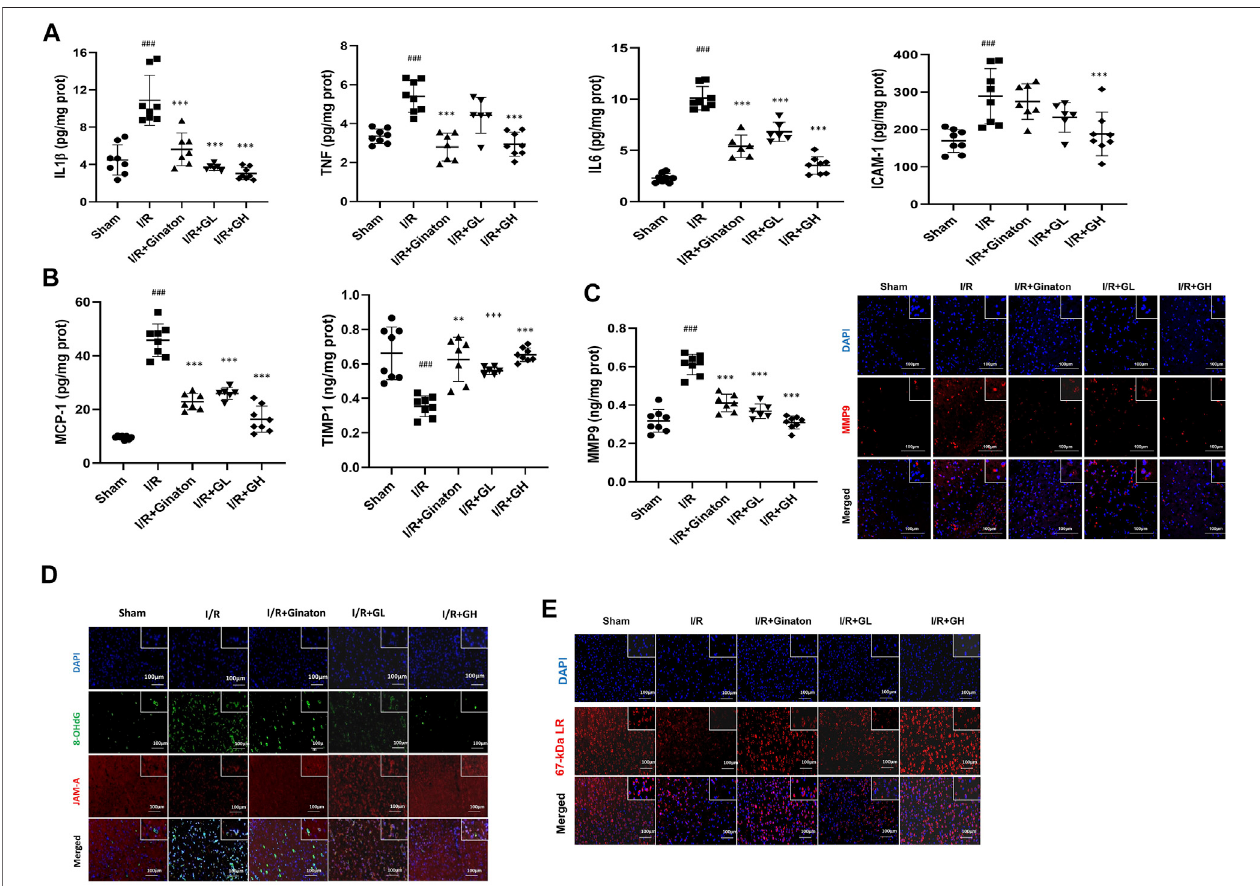
FIGURE6| GHIinhibitedin fl ammationandrestoredJAM-1andlamininexpression. (A – E) ELISAresultsofIL-1 β ,TNF,IL6,andICAM-1( n =6 – 8); (B) ELISAresults of TIMP1 and MCP-1 ( n = 6 – 8); (C) ELISA results of MMP9 ( n = 6 – 8) and IF for MMP-9 (red) in the cortex of rat brains, scale bar: 100 μ m; (D) IF for JAM-A (red) and 8- OHdG (green) in the cortex of rat brains. (E) IF for laminin (red) in the cortex of rat brains; the nuclei are indicated in blue, scale bar: 100 μ m, ### p < 0.001 compared with sham, * p < 0.05, *** p < 0.001 compared with the I/R group. GHI prevented neuron loss in MCAO-induced injury.